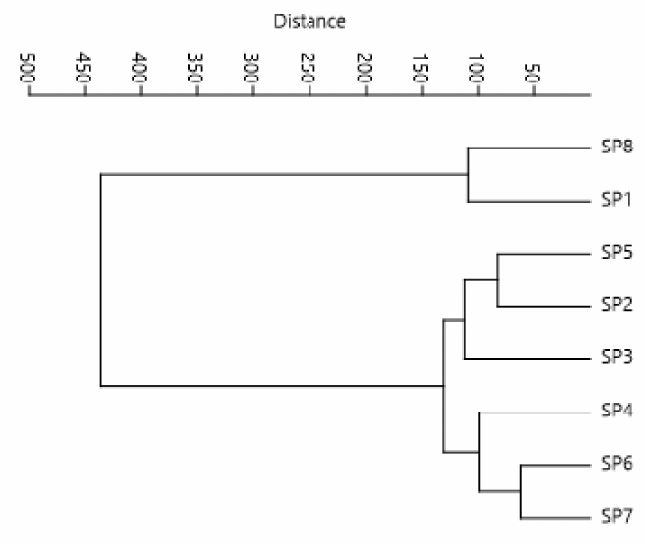
Figure 2. Hierarchical cluster dendrogram for elements and value indices at eight monitoring